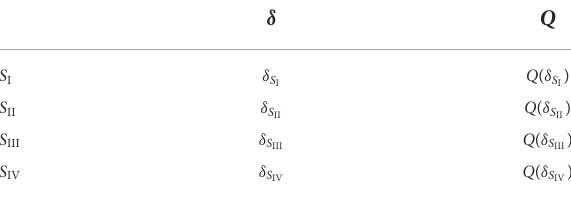
TABLE 4 The perceptual interference in each